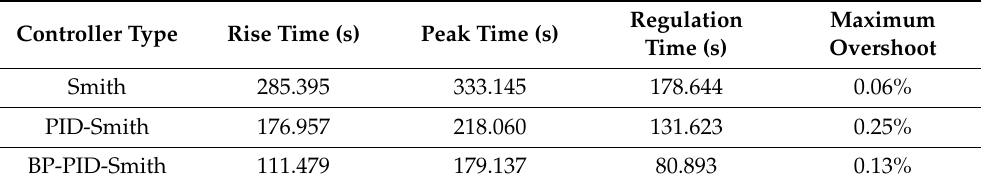
Figure 19. Regulation curves of the three controllers for a fertilizer flow rate of 0.73 m 3 /h. Table 5. Comparison of the dynamic performance of the three controllers at a fertilizer flow rate of 0.73 m 3 /h.